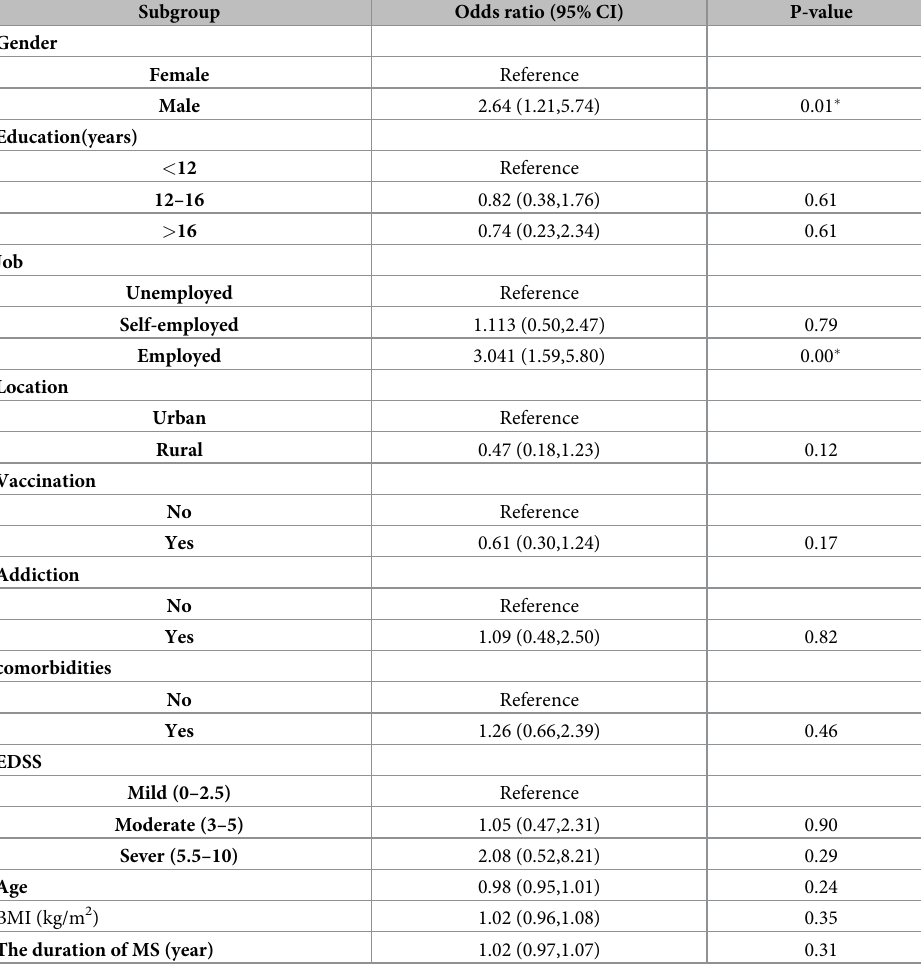
Table 3. Logistic regression analysis of factors associated with